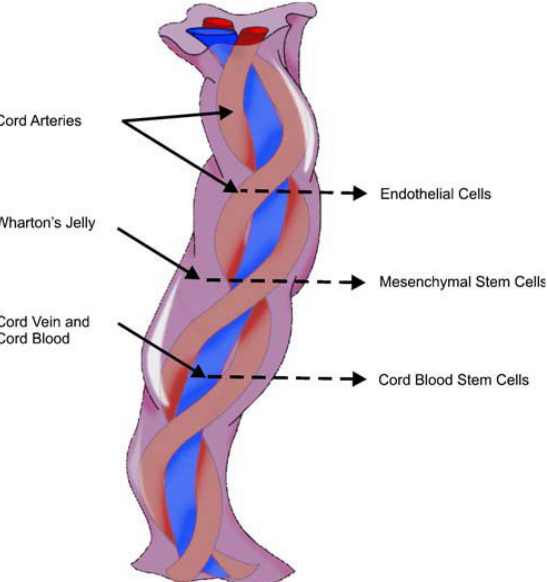
Figure 2. The anatomy of the umbilical cord. Reproduced from [10] with permission from Rightslink.